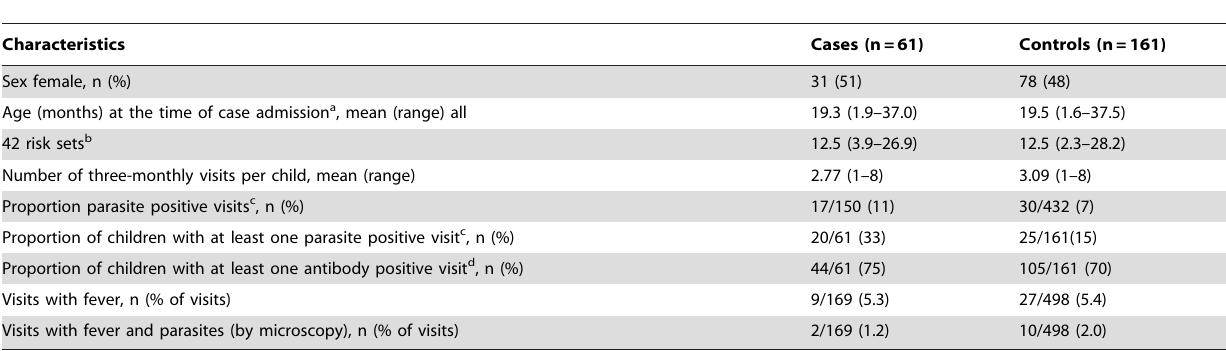
Table 1. Characteristics of the study